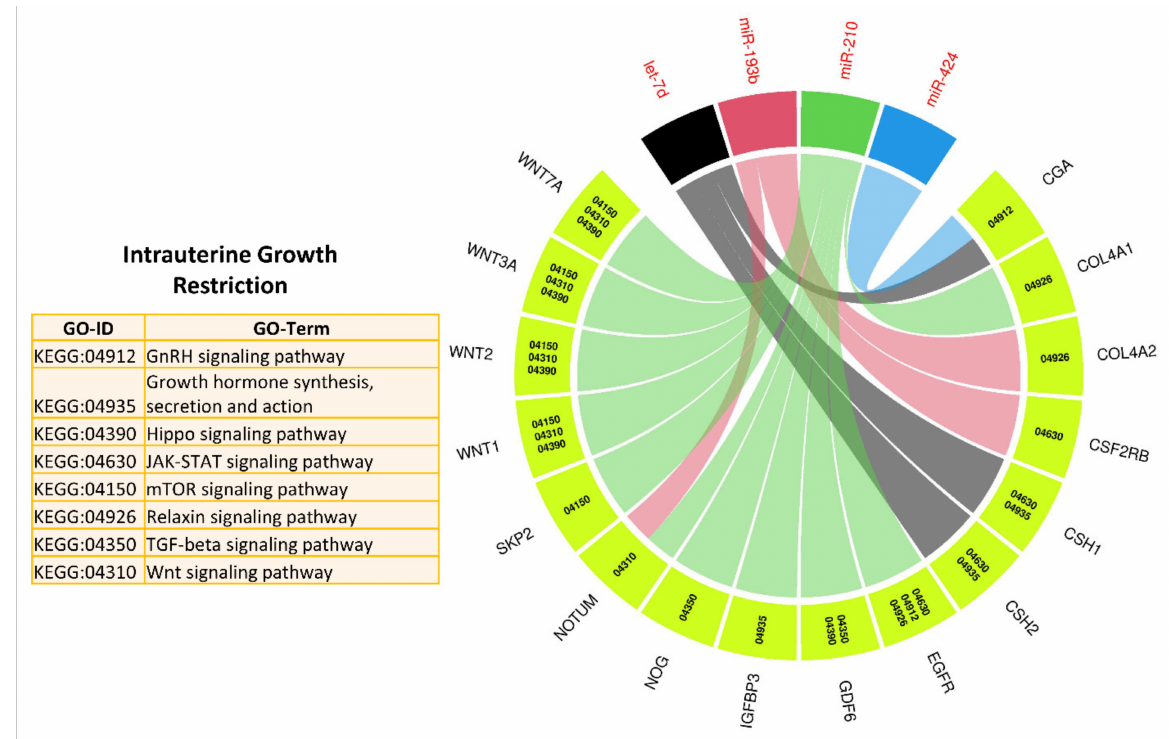
Figure 6. KEGG pathways enrichment analysis of target genes of IUGR-linked miRNAs from genes List 2, derived using ClueGO (version 2.5.1) and Cluepedia (version 1.5.7) plugin in Cytoscape (version 3.8.2) environment. A complete list of KEGG pathways regulated by IUGR-linked miRNAs is provided in Table